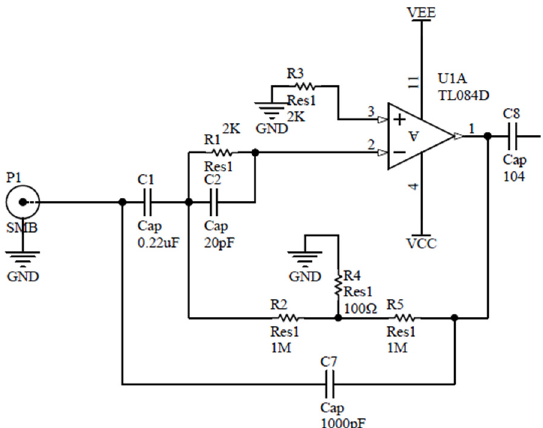
Figure 10. Schematic diagram of charge conversion circuit.